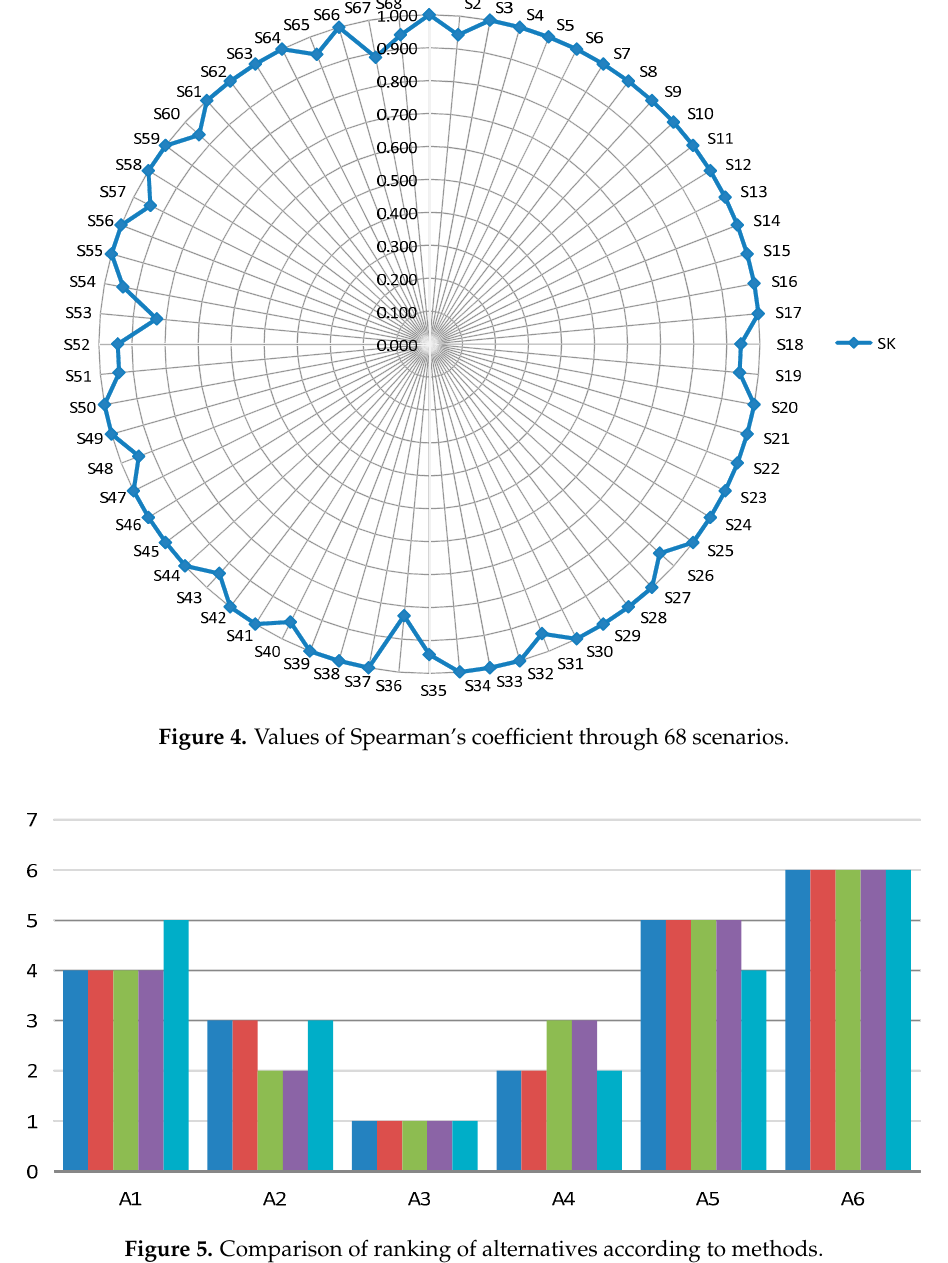
Figure 5. Comparison of ranking of alternatives according to methods.